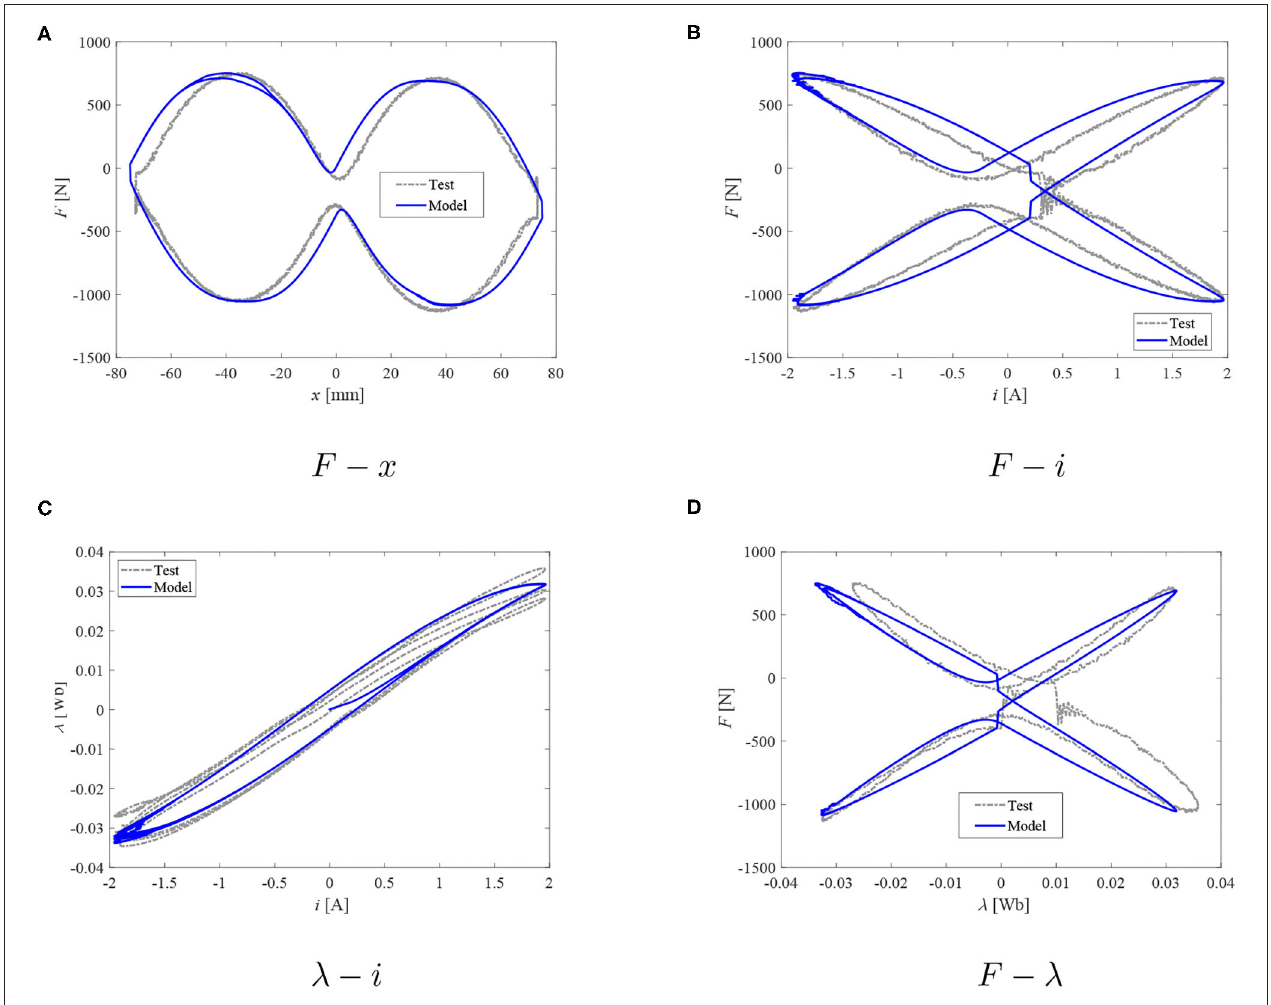
FIGURE 10 | Damper model: measured force and reconstructed flux vs. model data; I = 2.0 A. (A) F − x . (B) F − i . (C) λ − i . (D) F − λ